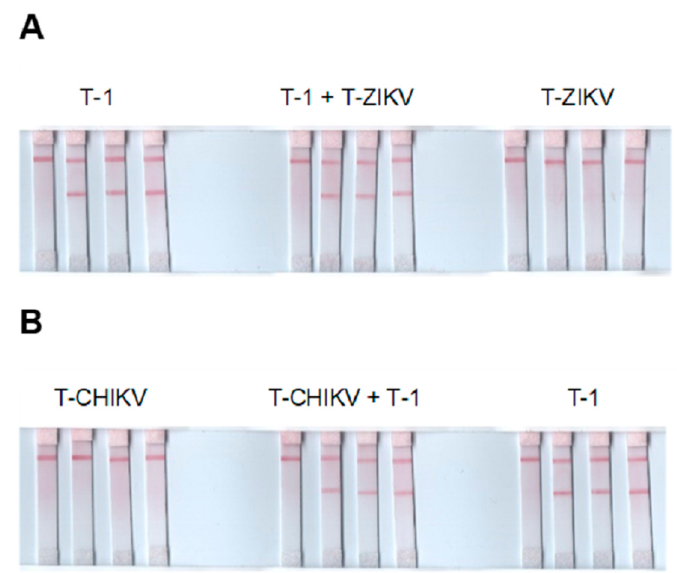
Figure 4. Selectivity test results. Sets of LFB tested with water and triplicates of 0.05 µM target as labeled ( A ) and ( B ).